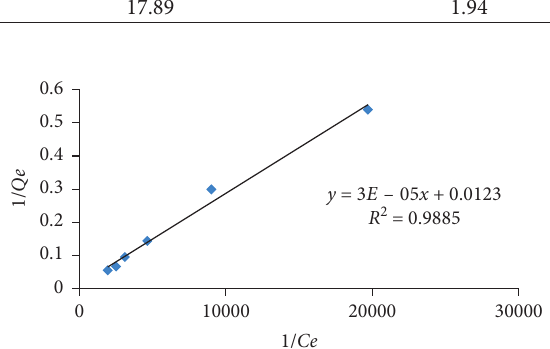
Table 5: Parameters of the graphical representation of the equation of Ho et al. for the adsorption kinetics of phenol. R 2 K 2 (min − 1 )